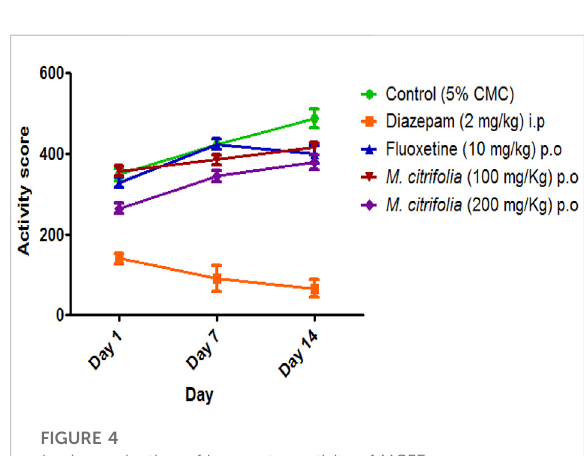
FIGURE 4 In vivo evaluation of locomotor activity of